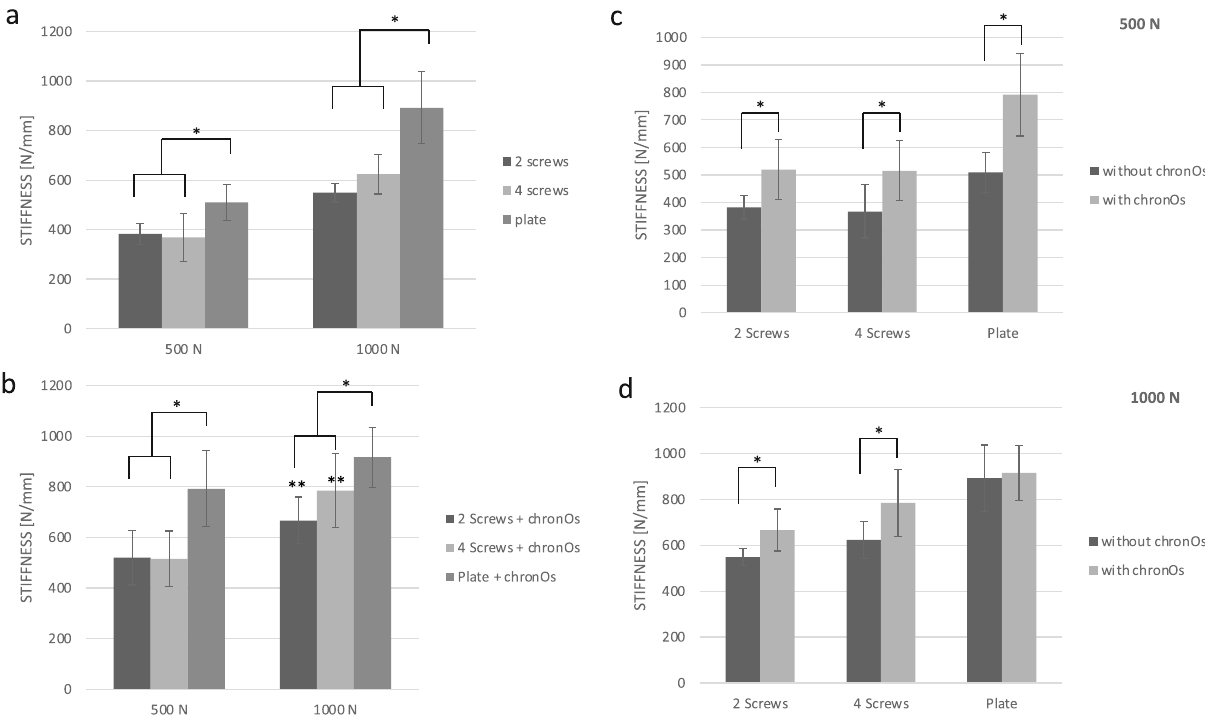
Figure 4. The results of the stiffness are shown. Means ± SD, significant differences are indicated by *(p < 0.05 between groups). ( a ) A higher stiffness revealed the plate osteosynthesis compared to the two screw osteosyntheses in both loading levels. ( b ) The plate exhibited a higher stiffness compared to the screw osteosyntheses in both loading levels when combined with cement. Additionally, in the 1000 N level, the 4 screws with ChronOs™ revealed a higher stiffness compared to the 2 screws with ChronOs™ (indicated by **). ( c ) A higher stiffness revealed the combination with bone cement compared to the same type of osteosynthesis alone in the 500 N loading level. ( d ) For the two screw osteosyntheses a higher stiffness was determined for the combination with bone cement compared to the same type of osteosynthesis without bone filler in the 1000 N loading